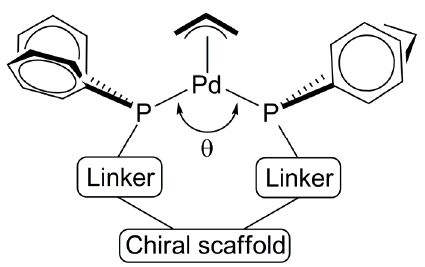
Figure 7. Model for ligand